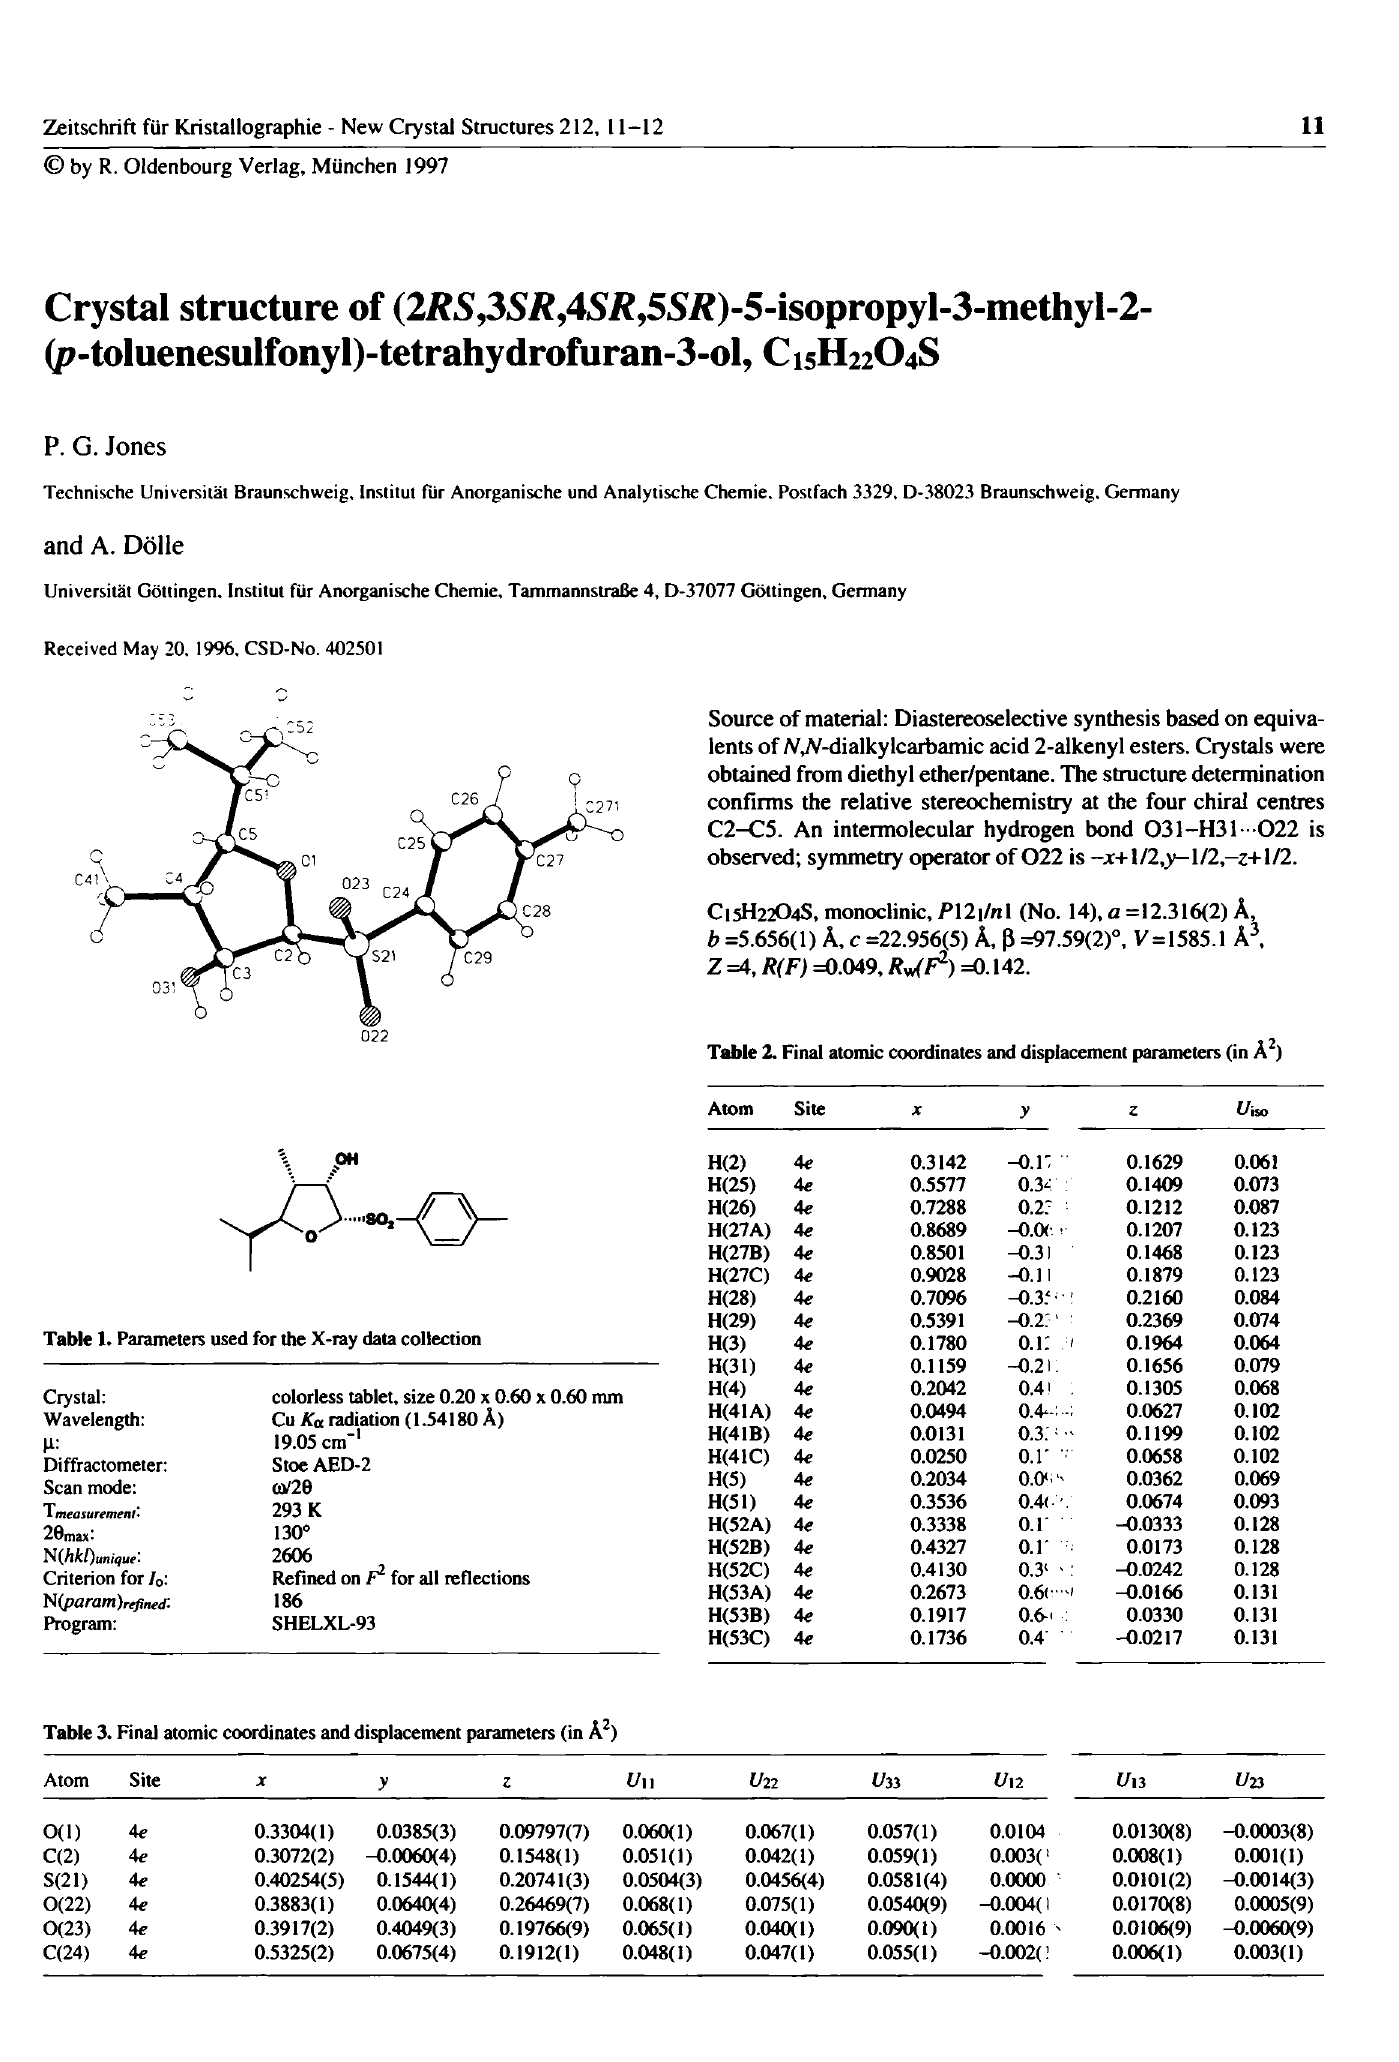
Table 3. Final atomic coordinates and displacement parameters (in A 2 ) Atom